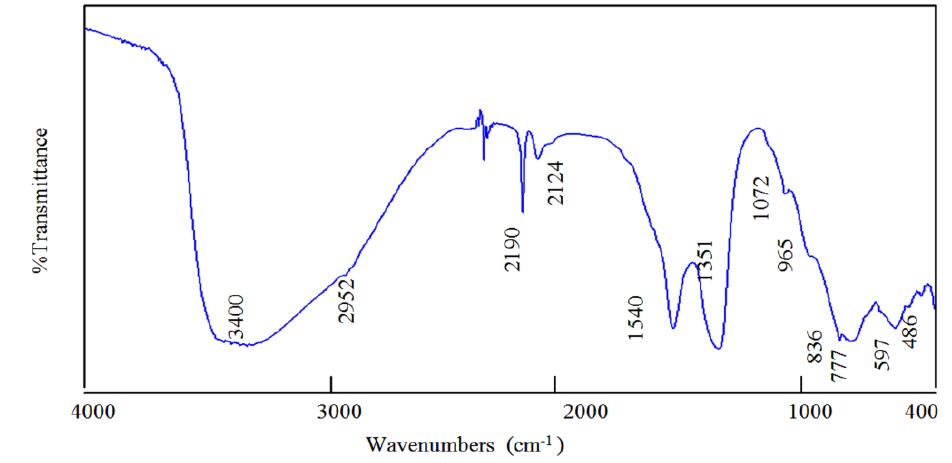
Figure 3. FT-IR spectrum of the CoFe 2 O 4 -supported Co-Fe LDH.